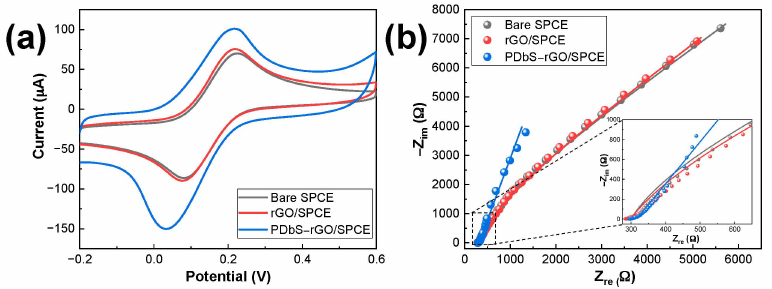
Figure 2. ( a ) CV curves for different SPCEs at a scan rate of 50 mV s − 1 ; ( b ) Nyquist plots for different SPCEs in 5 mM K 3 [Fe(CN) 6 ] prepared in 0.1 M KCl. The scattered dots in ( b ) represent the experimental data, and the lines are the theoretical